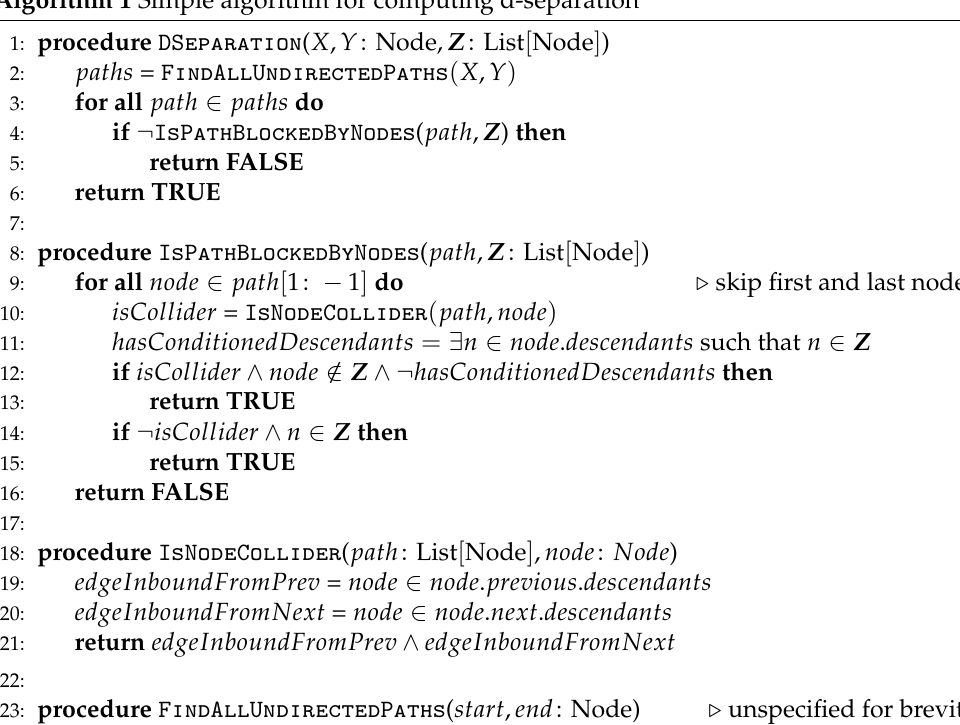
Algorithm 1 Simple algorithm for computing